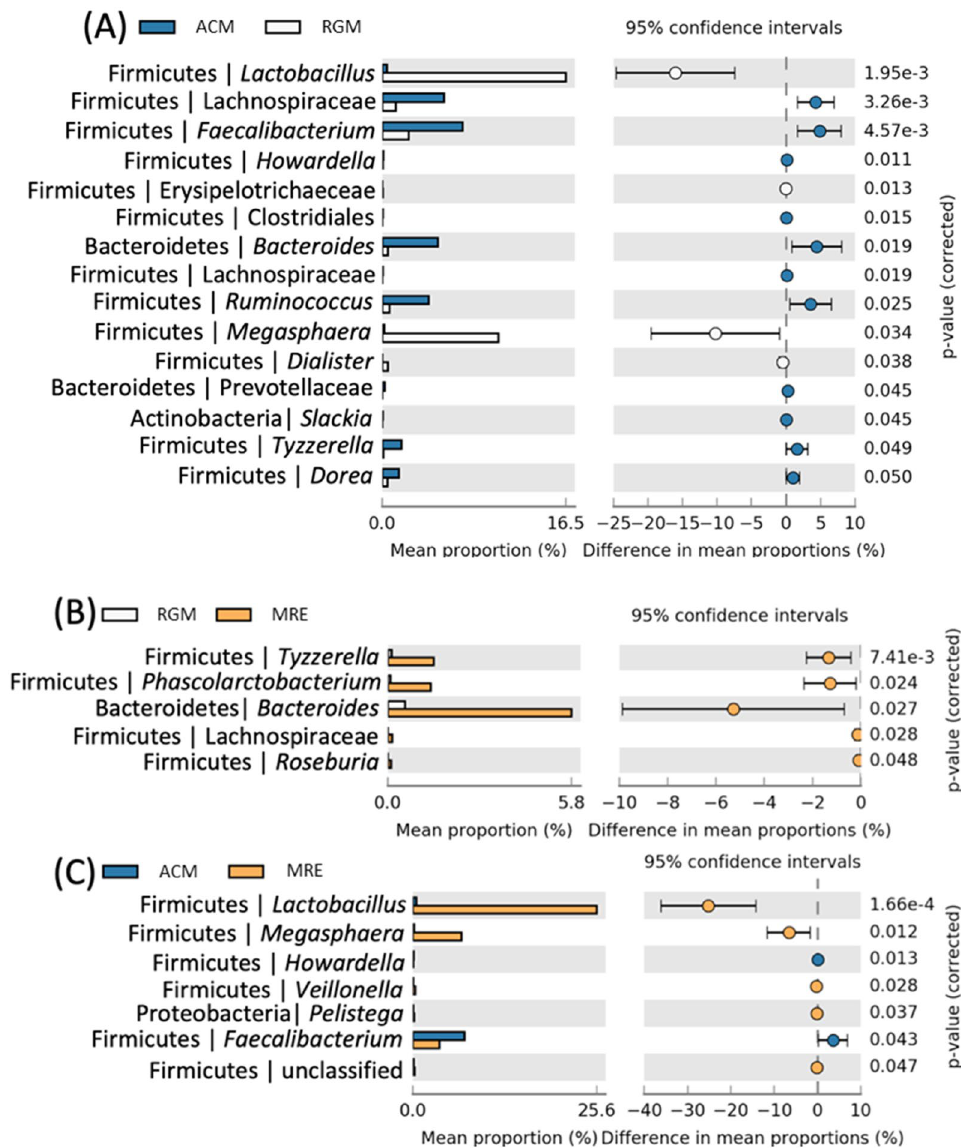
Figure 5. Bacterial genera composition in diarrheal fecal samples from dairy calves fed different liquid diets. Scatter-plot based on Welch’s t test with Benjamini–Hochberg correction constructed in STAMP (P < 0.05). ( A ) differences between AWM and WM; ( B ) differences between WM and MR; and ( C ) AWM and